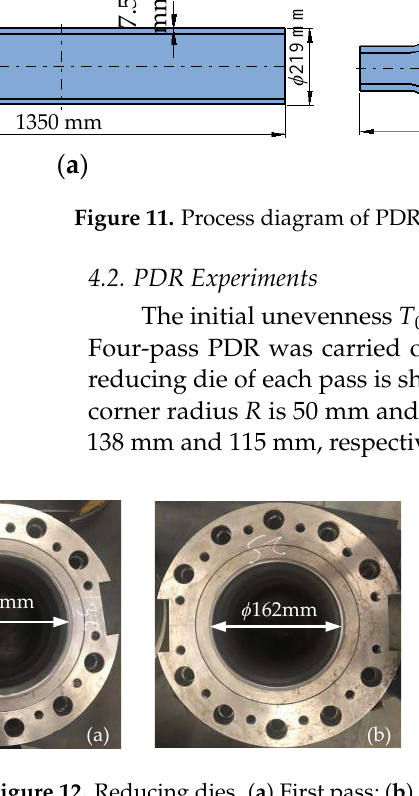
right slider of hydraulic press from the tube end to the inner side at the speed of 10 mm/s.